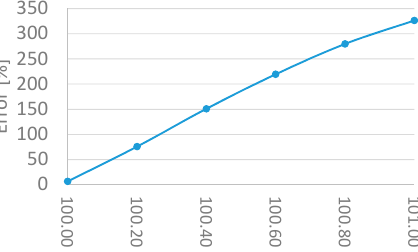
Figure 14. Estimation error of missing readings in initial part with respect to the error in the estimated voltage at the pole-transformer.